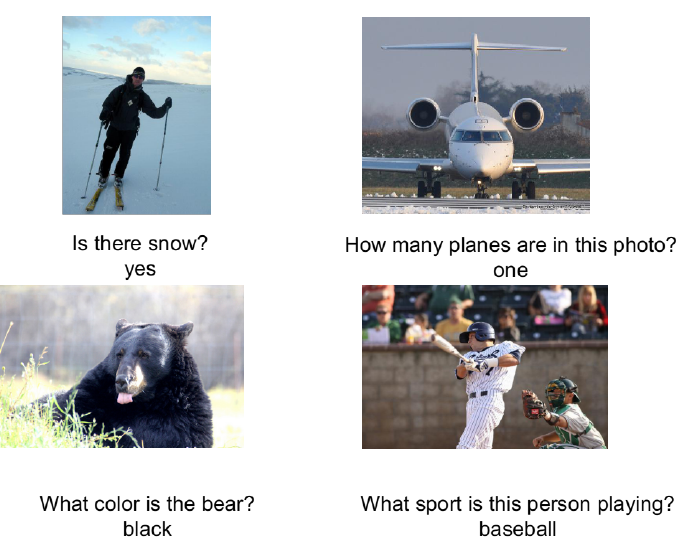
Figure 1. Examples of training questions and their correct answer from the VQA v2